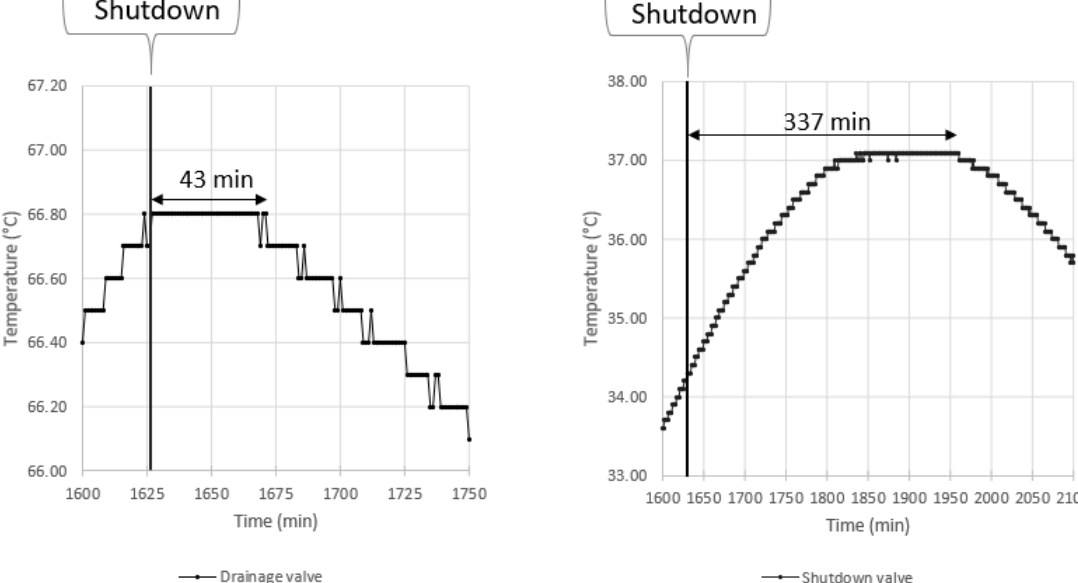
Figure 13. Thermal response time from shutdown to temperature decline for the drainage valve (left panel) and shutdown valve (right panel); temperature data from the second shutdown, at 1627 min.